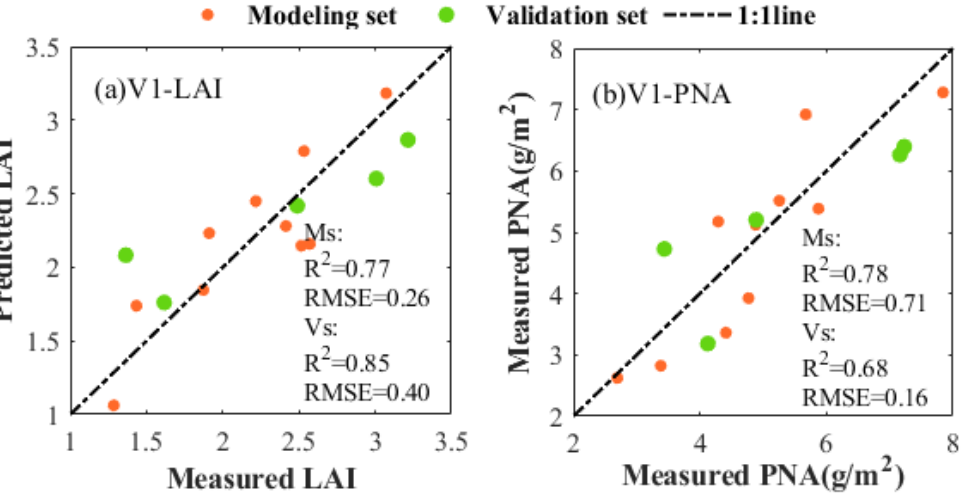
Figure 13. Scatterplots of measured and predicted ( a ) leaf area index (LAI) and ( b ) plant nitrogen accumulation (PNA) in 2019.